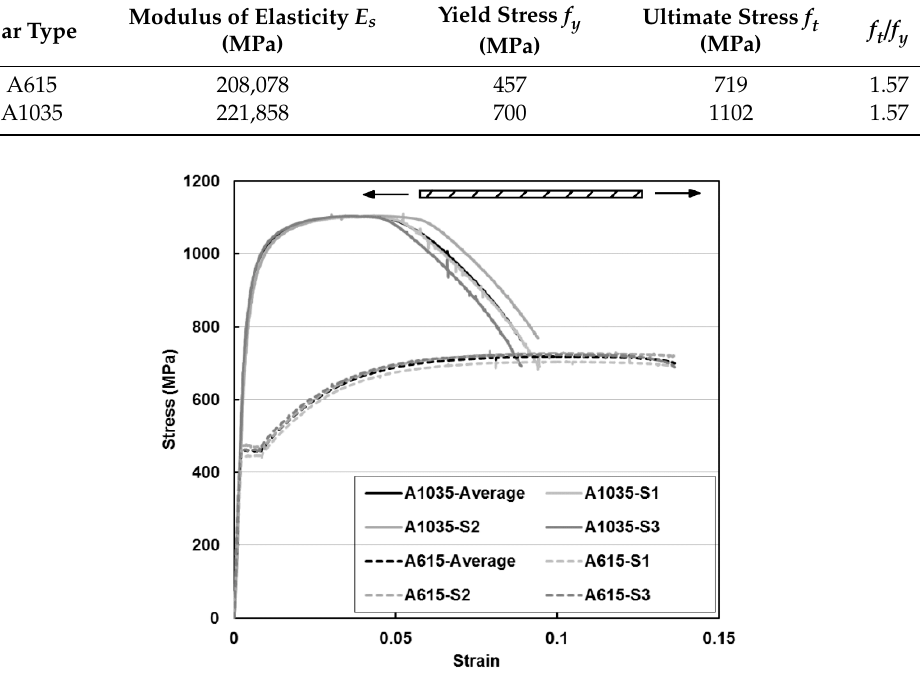
Figure 4. Average stress versus strain curves of A615 and A1035 rebar used in this research (Adapted from [7]).